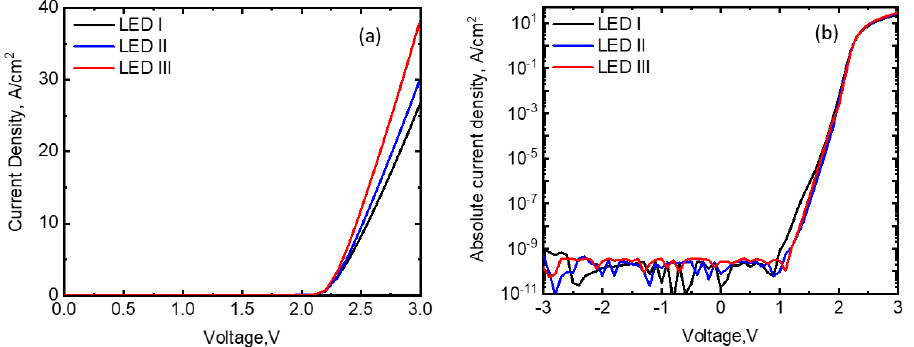
Figure 3. I - V characteristics of the experimental LEDs with current plotted in ( a ) linear scale and ( b ) logarithmic scale.